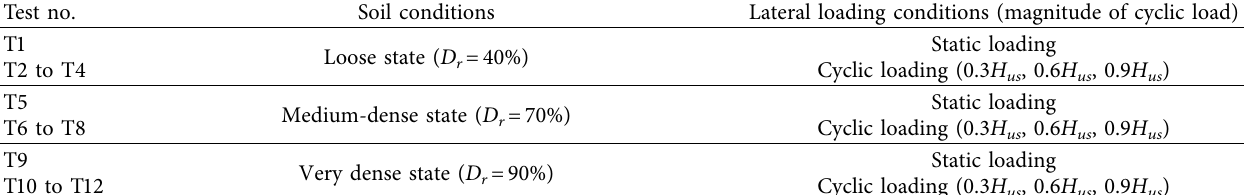
Table 4: Model pile testing conditions.